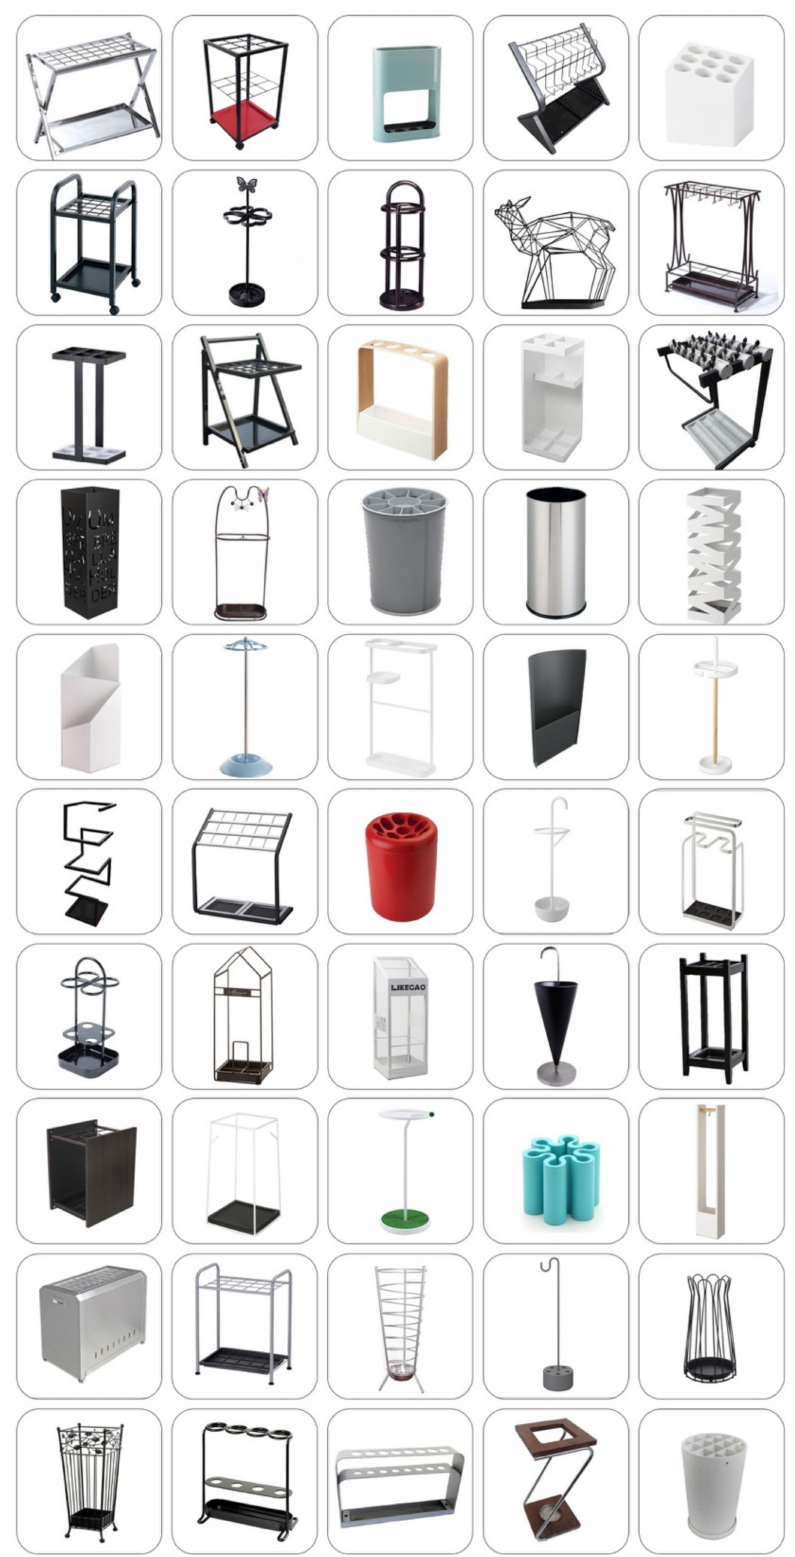
Figure 2. Collection of commercially available umbrella-stand